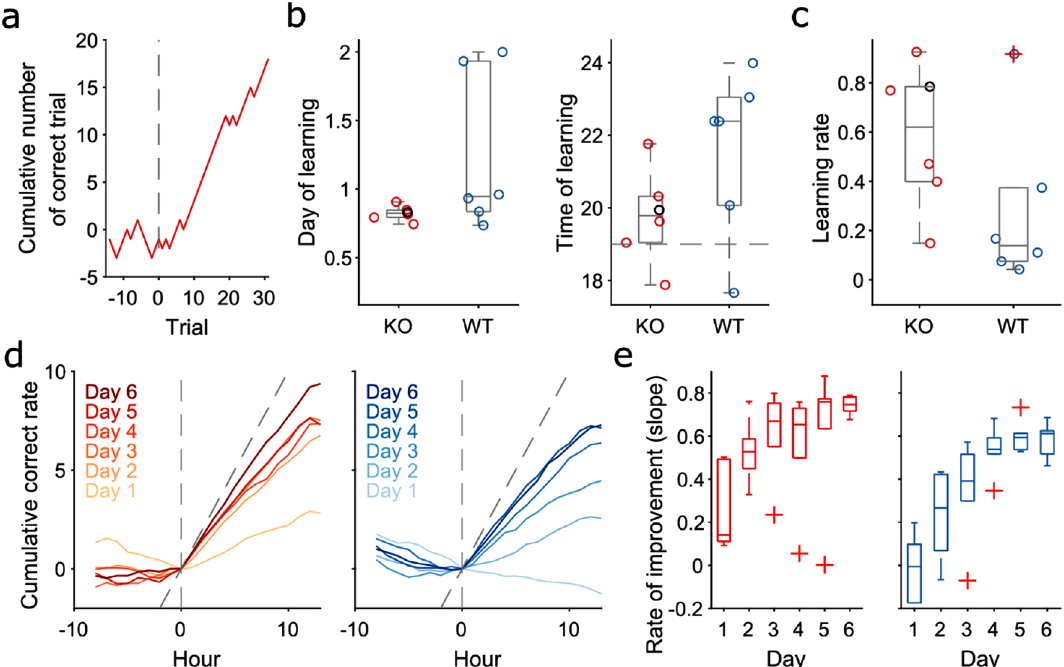
Figure 3. TAAR5 mice improve at a higher speed. ( a ). Cumulative number of correct trials for an example subject around the learning trial (trial 0). This curve increases (+ 1) when correct trial and decreases (1) when error. For each subject, we identified the learning trial (trial 0) as the trial with maximum inflexion between the curve before and after the trial. Vertical dashed line identifies the learning trial for this example subject. ( b ). The day (left panel) and time (right panel) of the learning trial for each subject. Boxplot distribution shows median, interquartile and extreme value of the distribution. Each circle is a subject, and the black circle is the example subject in panel a. Horizontal dashed line in the right panel identifies the start of the dark phase. ( c ). Comparison of the learning rate between KO and WT mice. Each circle is a subject. The learning rate was measured as the difference between the slopes of the regression curves before and after the leaning trial (panel a). ( d ). Cumulative correct rate over days for each hour around the light off (hour zero). Vertical dashed line identifies the time of light off; diagonal dashed line identifies the optimal correct rate (where all the trials are correct). Red curves are KO mice, blue curves are WT mice. The color shade reflects the days of training (light color = first day, darker color = last day). ( e ). The slope of the regression curves after the time of light off in panel d identifies the rate of improvement over days for each group. (2-way ANOVA: significant effect of time p < 0.005, F = 13.58 and group p < 0.005, F =